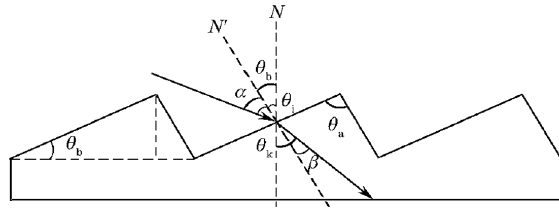
Figure 2. Structure model of reflective blazed grating. According to the grating equation.